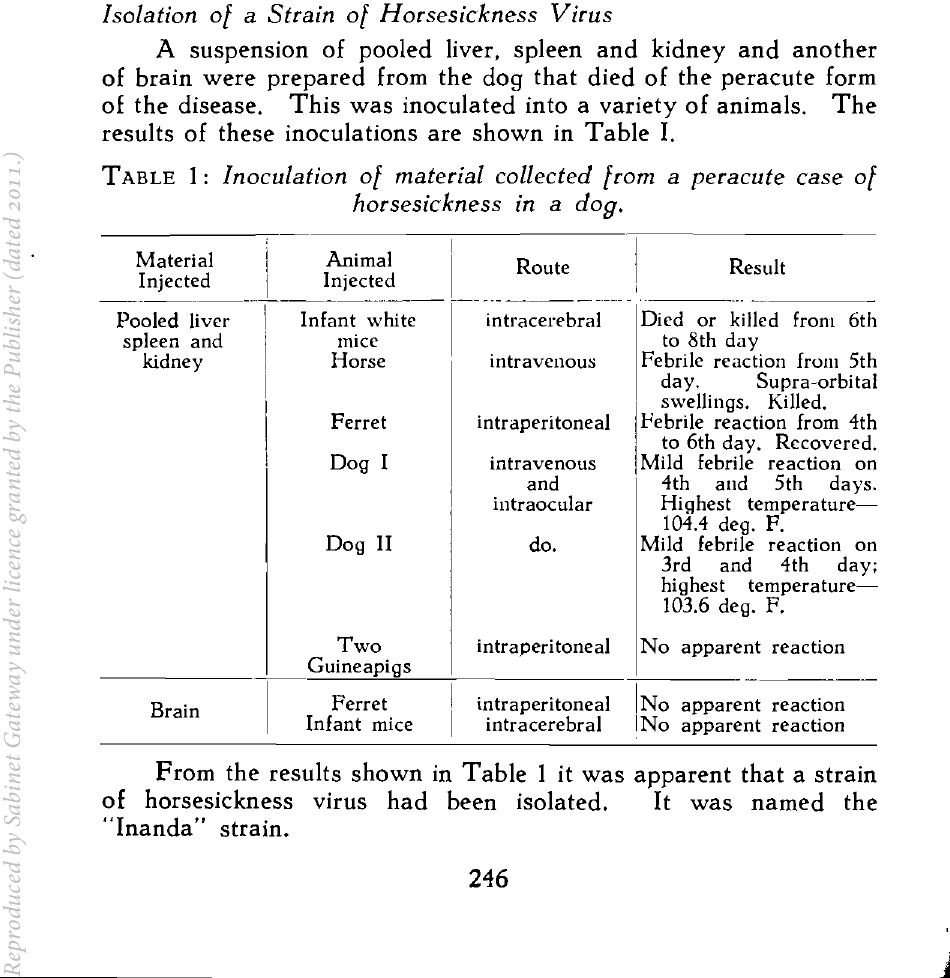
TABLE I: Inoculation of material collected from a peracute case of horsesickness in a